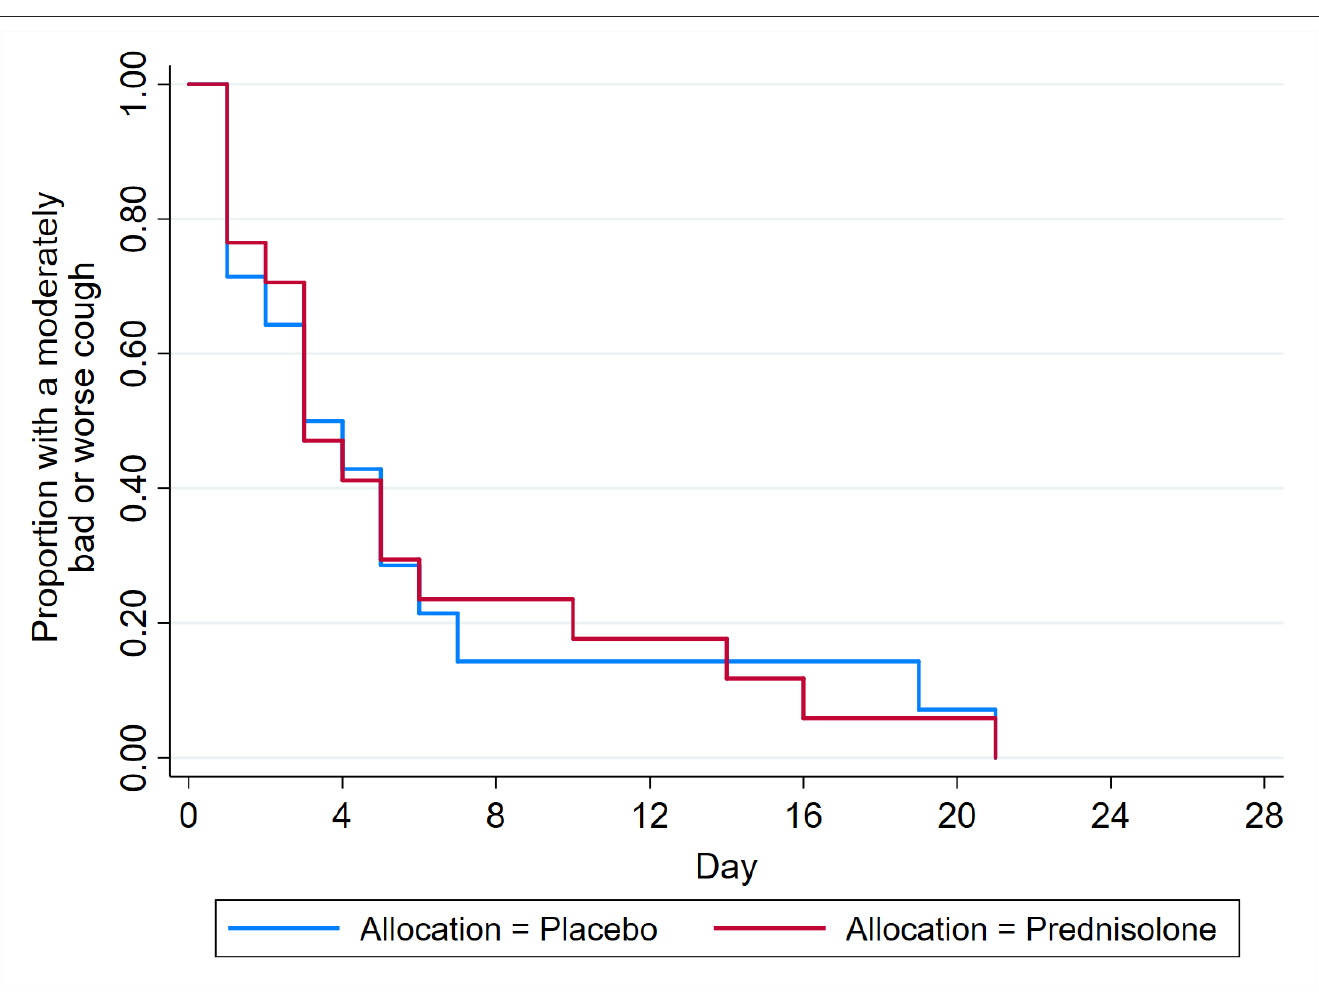
Figure 1 Kaplan–Meier analysis of time to recovery from moderately bad or worse cough (main analysis